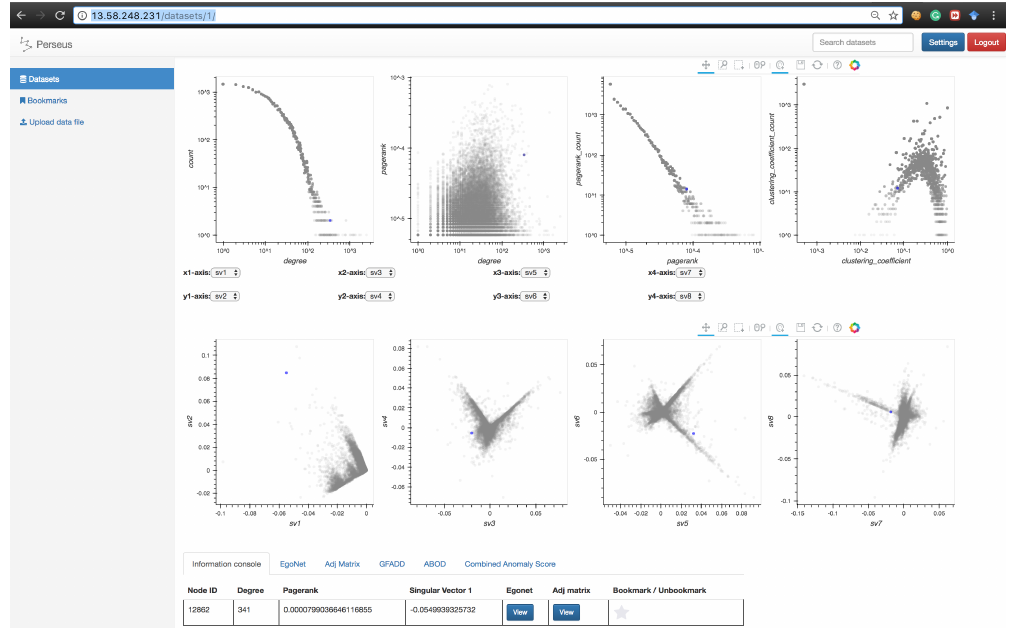
Figure 11. Illustration of running P ERSEUS -H UB on the cit-HepTh (citation in high energy physics theory) graph. To explore the spike patterns in the singular vector plots, extreme points on the spikes are selected and explored. Only one is shown in this case to obtain the node ID.